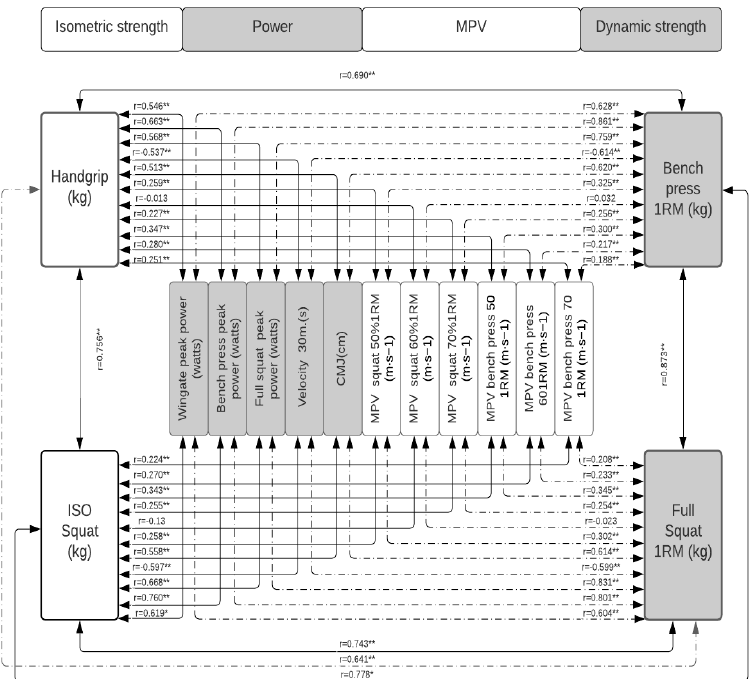
Figure 1. Correlation between measures of absolute maximum strength and power in the total population. Significance: * p < 0.05; ** p < 0.001.